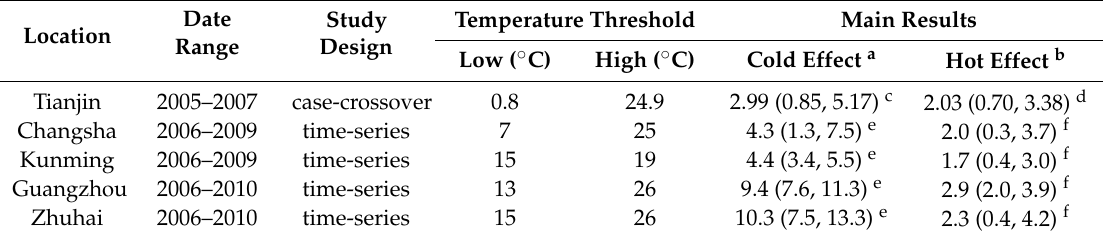
Table 6. Study results of cold- and heat-related mortality in other Chinese cities using double-threshold DLNM.